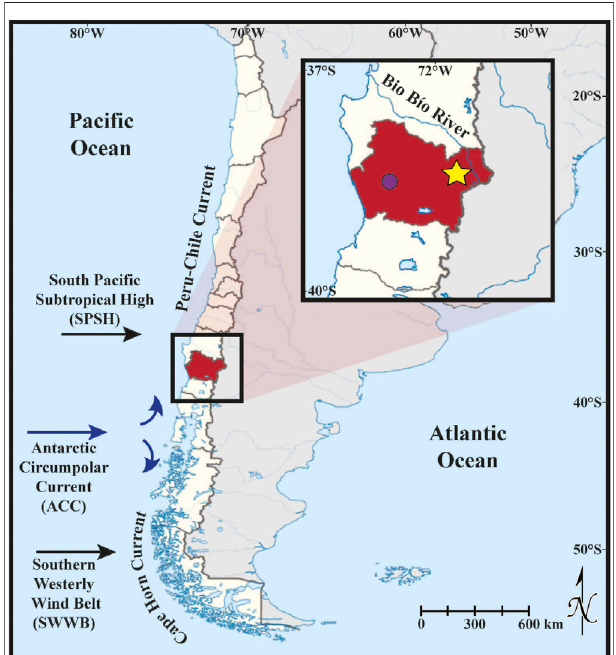
FIGURE 1 | Map of South America with Chile (beige with brown outline). Relative positions of the winds associated with the dominant precipitation bearing South Paci fi c Subtropical High (SPSH), and Southern Westerly Wind Belt(SWWB)duringtheAustralsummermonthsareindicatedwithblack arrows. Major oceanic currents near the study site (Antarctic Circumpolar Current, Peru-Chile Current and Cape Horn Current) are indicated with blue arrows. Inset box shows the proximity of the identi fi ed modern climatic transition zone of ~37.5 ° S (Muñoz et al., 2016) to the nearby Araucanía region of Chile ( fi lled in red). A yellow star identi fi es the location of Monte Sierra Nevada (~38 ° S), and the location of the Temuco weather station used for the modeling analysis is represented by a purple